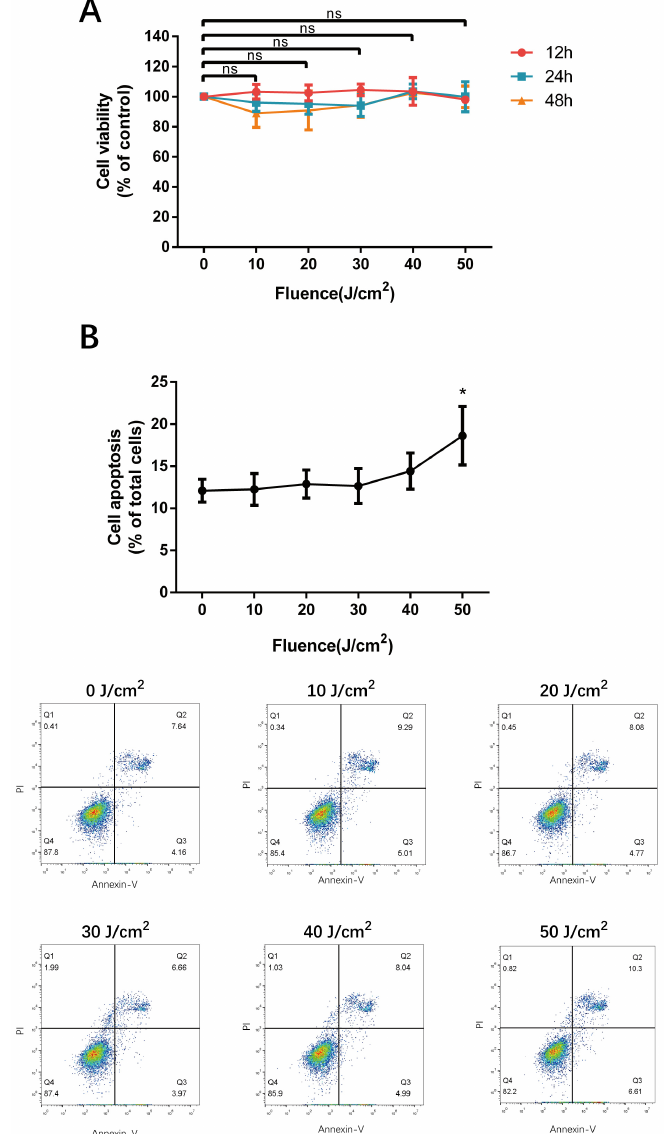
Figure 1. The effect of 590 nm LED irradiation on cell viability and cell apoptosis of HMEC-1. ( A ) Cell viability of HMEC-1 measured using CCK-8 assay 12 h, 24 h and 48 h after 0–50 J/cm 2 590 nm LED illumination. Results were normalized to the control. ( B ) Apoptosis of irradiated cells detected by flow cytometry (24 h, Annexin-V FITC & PI staining). Data are presented as means ± SD in independent experiments. n = 3; *, p < 0.05. n.s., no